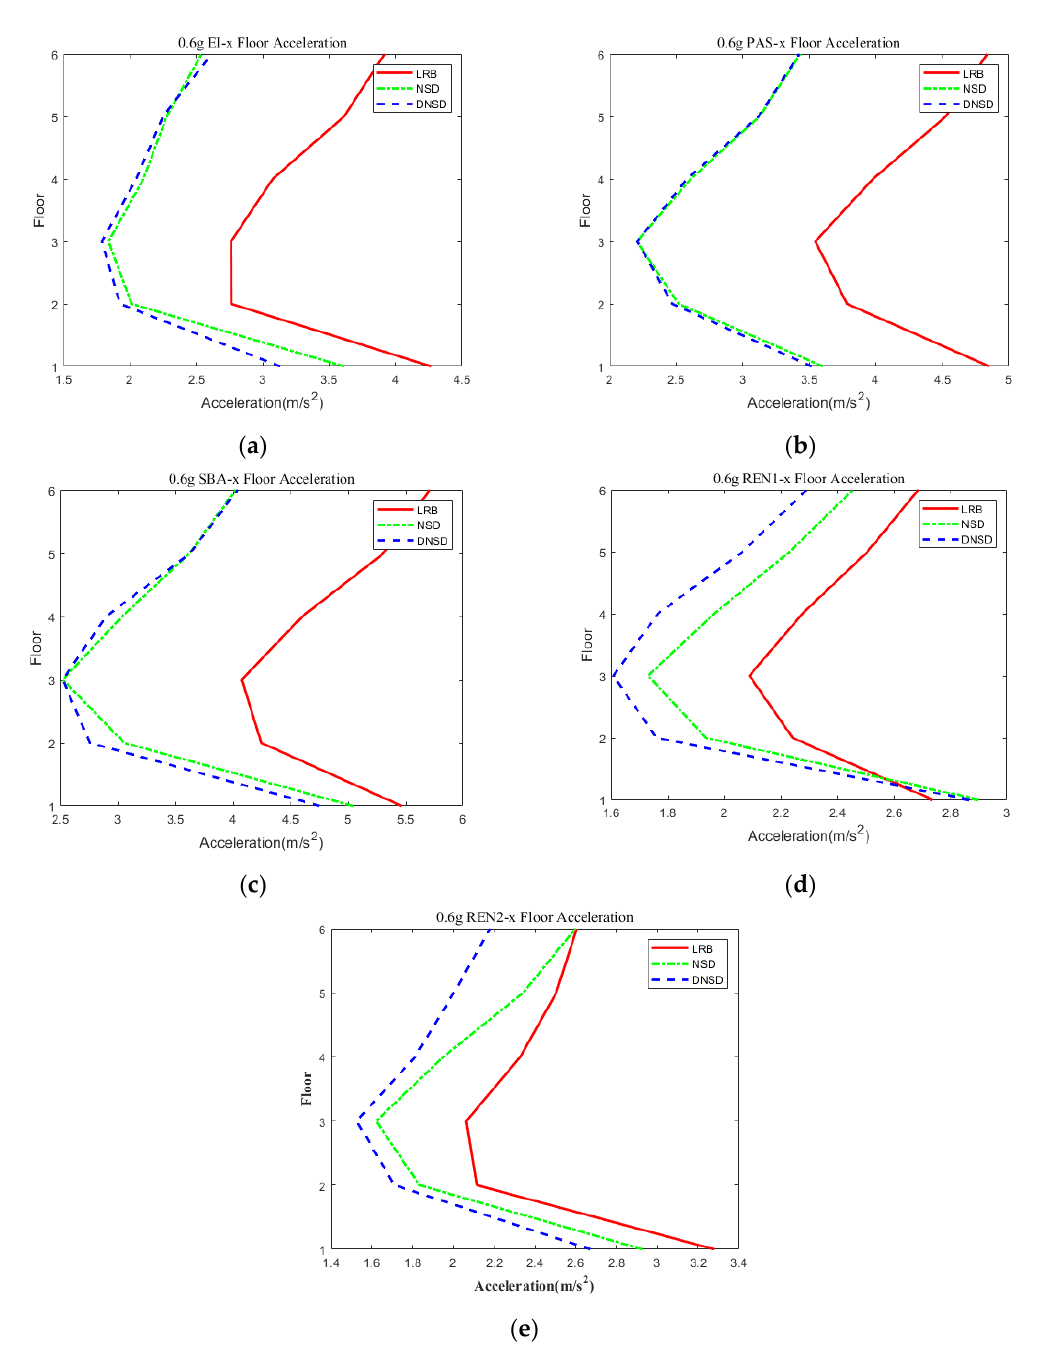
Figure 24. Comparison of floor accelerations among three models under different earthquake waves at a peak of 0.6 g. ( a ) Floor acceleration at 0.6 g peak of El wave. ( b ) Floor acceleration at 0.6 g peak of PAS wave. ( c ) Floor acceleration at 0.6 g peak of SBA wave. ( d ) Floor acceleration at 0.6 g peak of REN1 wave. ( e ) Floor acceleration at 0.6 g peak of REN2 wave.